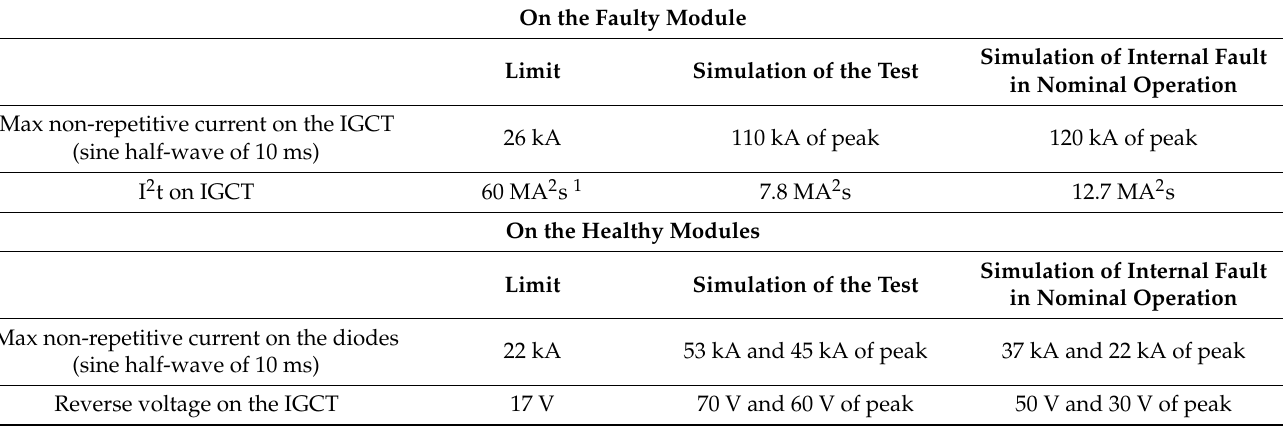
Figure 14. Simulation of the test with the arc related to the flexible bar detachment lasting for 1.5 ms—current on diodes of the two non-sacrificial modules. Table 3. Limit on the components and values obtained in the test